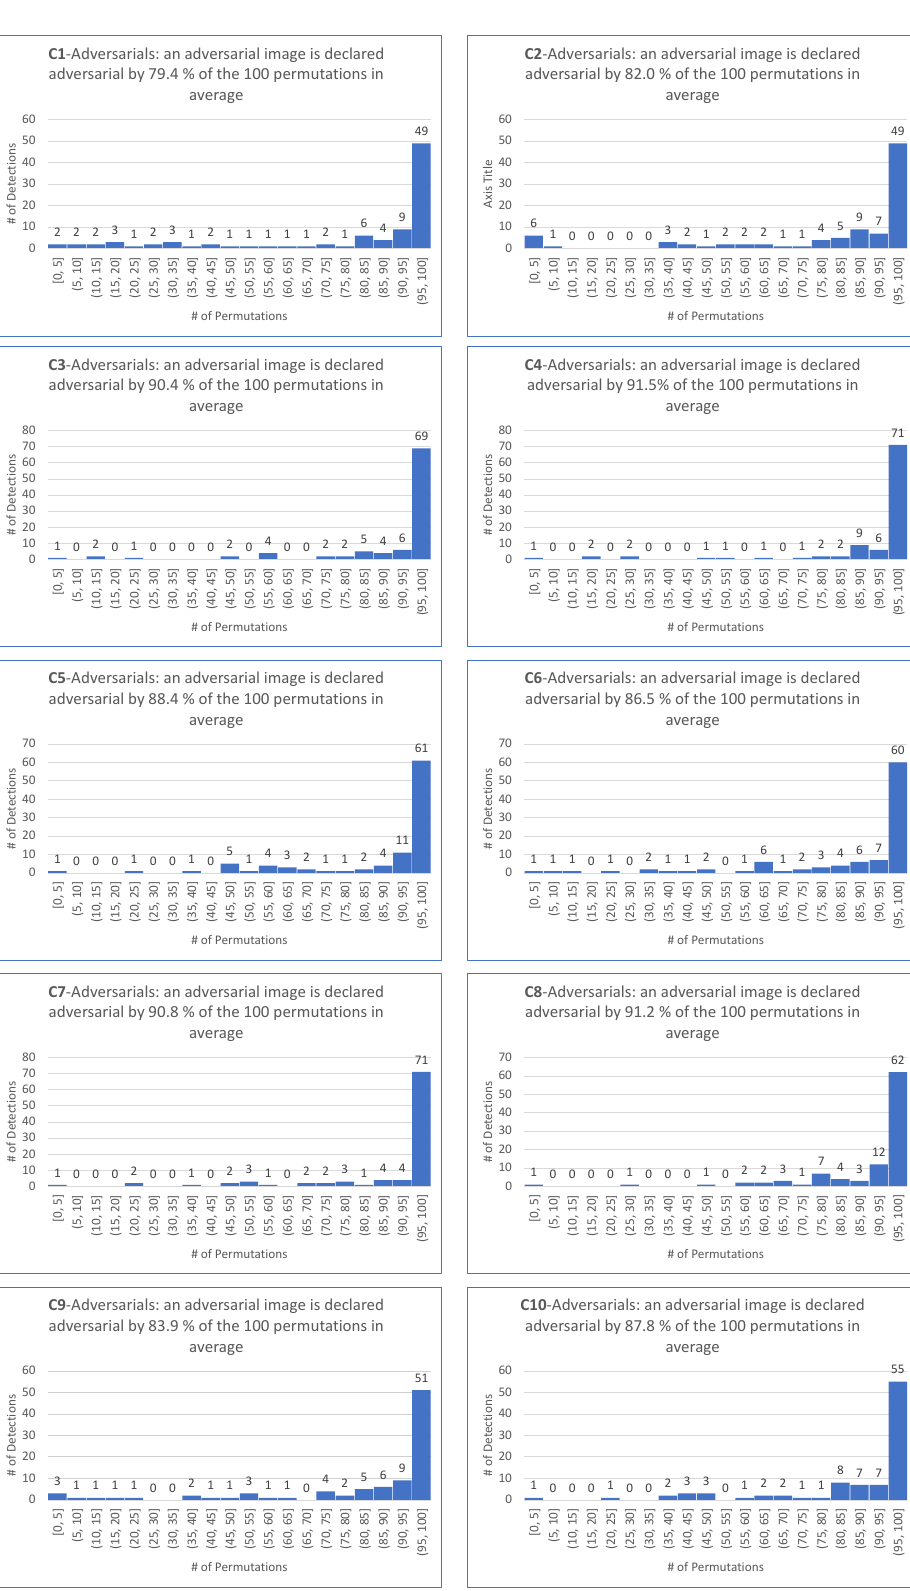
Figure A12. ShuffleDetect results for adversarial images generated by the CW Inf-untargeted attack on C = C for 1 ≤ k ≤ 10 over 100